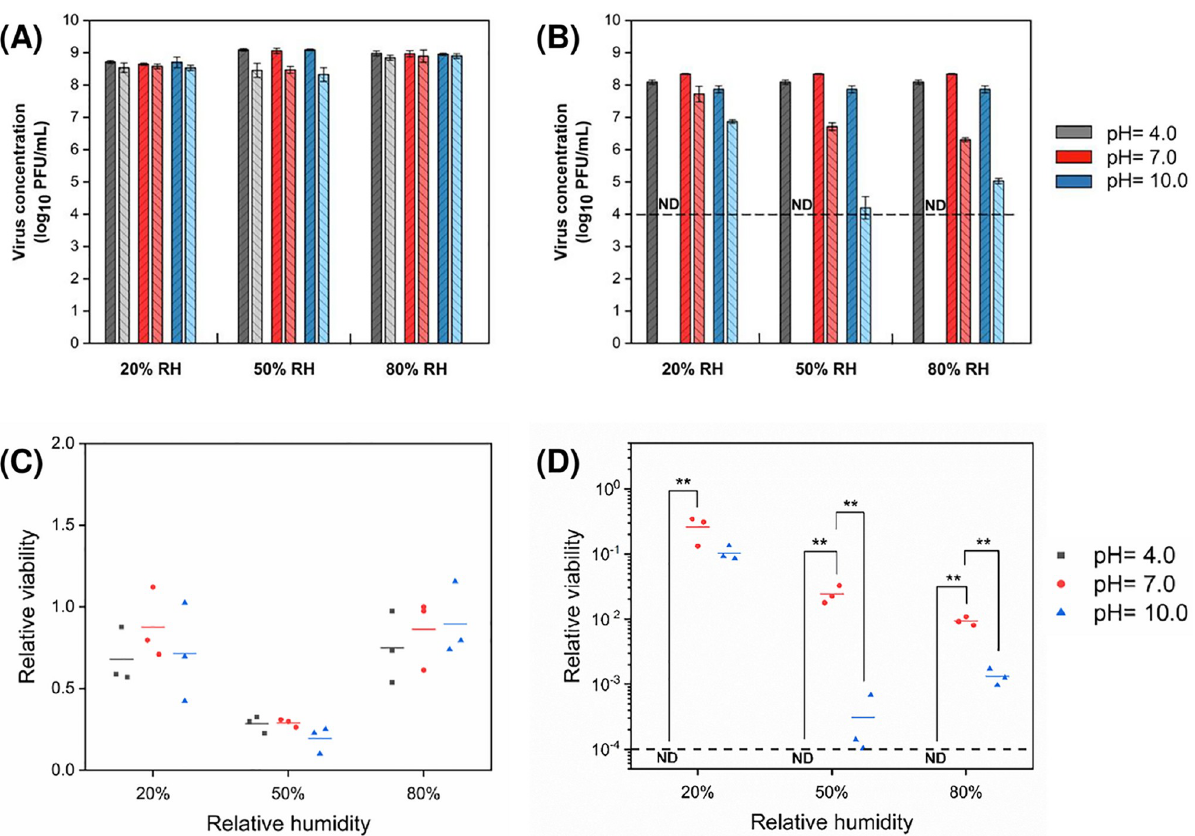
Fig 3. Concentration of bacteriophages (A) MS2 and (B) F 6 in droplets with different initial pH values before (dark bars) and after (light bars) 1 h exposure to low, intermediate, and high RH (mean ± s.d. of triplicates). Relative viability of (C) MS2 and (D) F 6 after 1 h exposure (lines show the mean of triplicates). The number of virions in droplets at the start of the exposure experiments was 10 5 − 10 6 PFU. The dark gray dashed line indicates the detection limit (10 4 PFU/mL) of plaque assay. ND indicates no viable virus was detected.